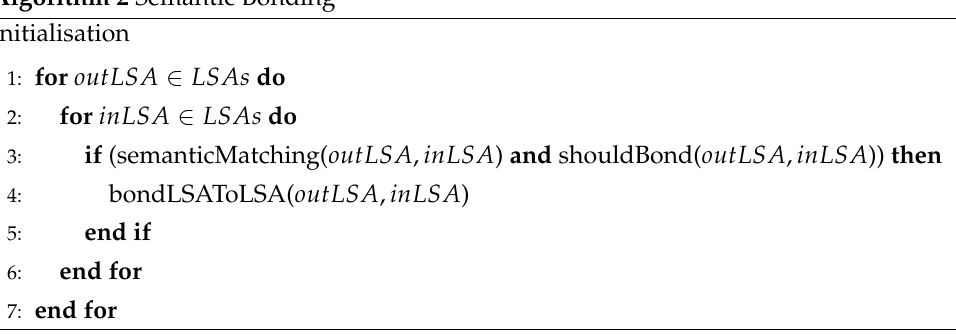
Algorithm 2 Semantic